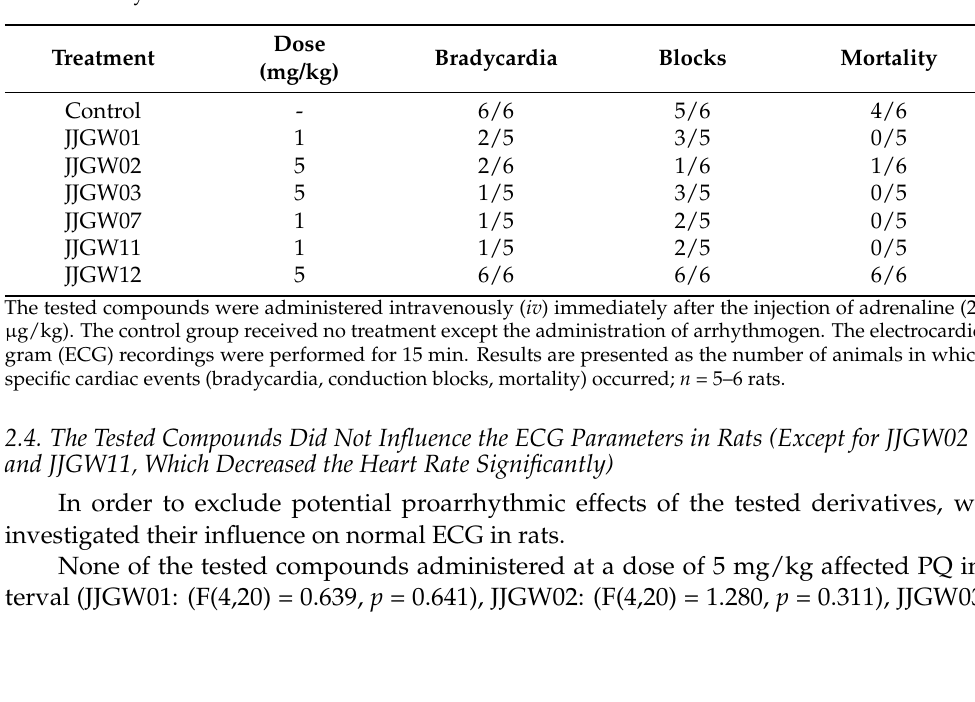
Table 4. The therapeutic antiarrhythmic activity of arylpiperazine derivatives in the adrenaline ‐ induced arrhythmia model in rats.